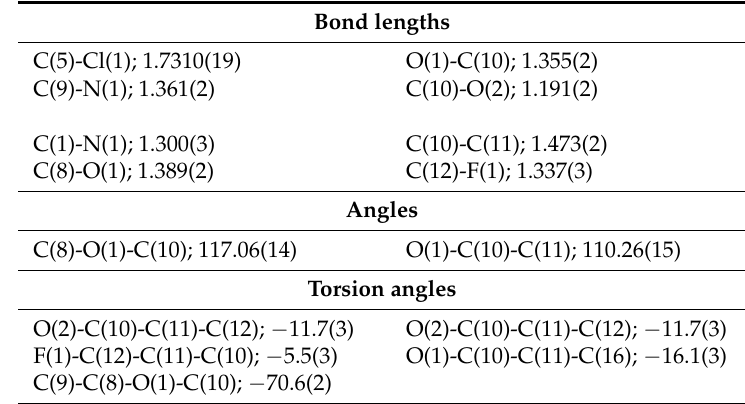
Table 1. Selected bond lengths [Å], angles [ ◦ ] and torsion angles [ ◦ ] for compound 3 .